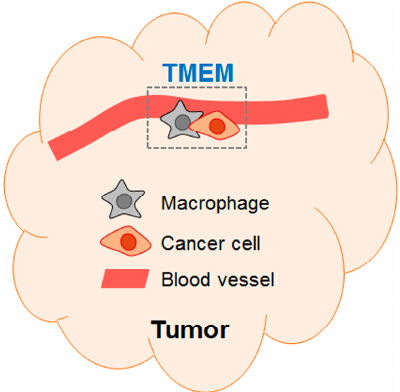
Figure 1. A schematic of TMEM (tumor microenvironment metastasis). The schematic shows a TMEM composed of a macrophage and a cancer cell at peri-vascular location (first named by Robinson et al. [29]).